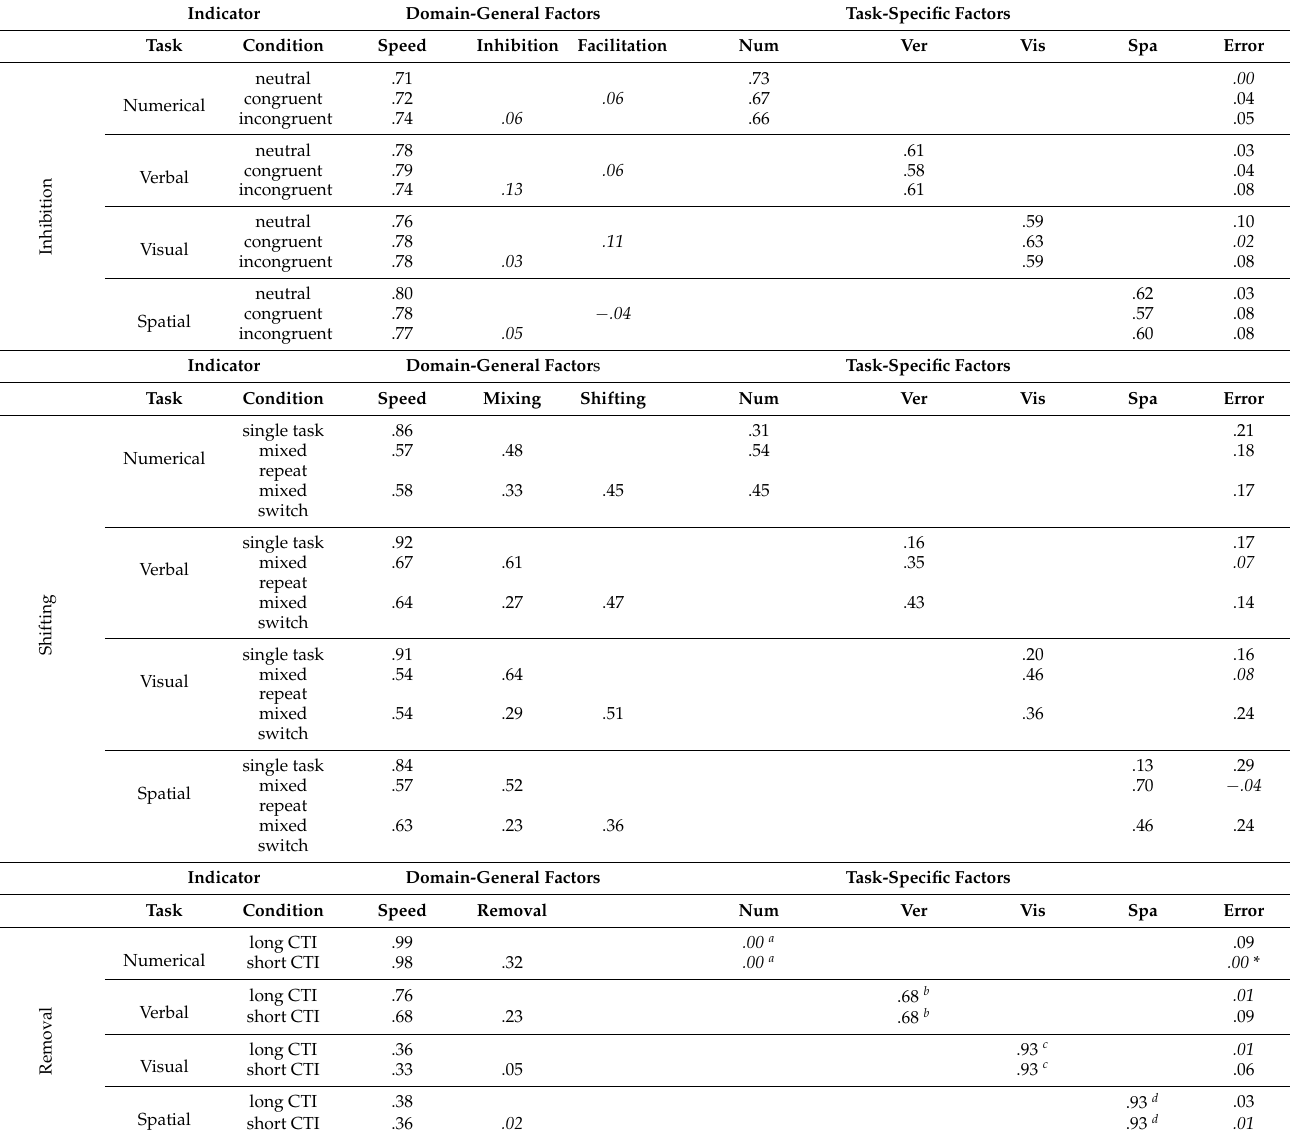
Table 4. Factor loadings and error variances for the unconstrained measurement models of the executive processing